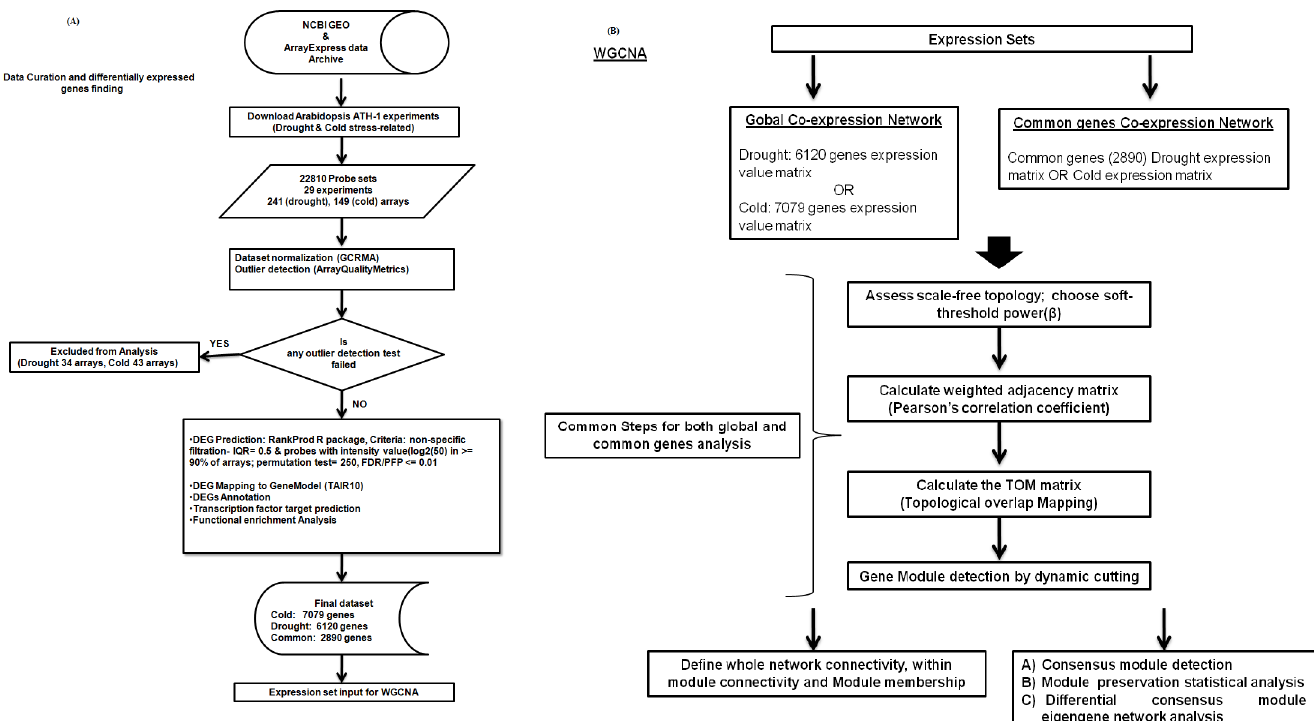
Fig 1. Workflow for data collection, curation and co-expression network analysis. (A) In total 29 series (26 series from NCBI-GEO and 3 series from ArrayExpress) comprising of 241 and 149 Affymetrix A . thaliana arrays related to drought and cold stress were used in the analysis. (B) Workflow describes the steps for co-expression network generation and consensus module detection.